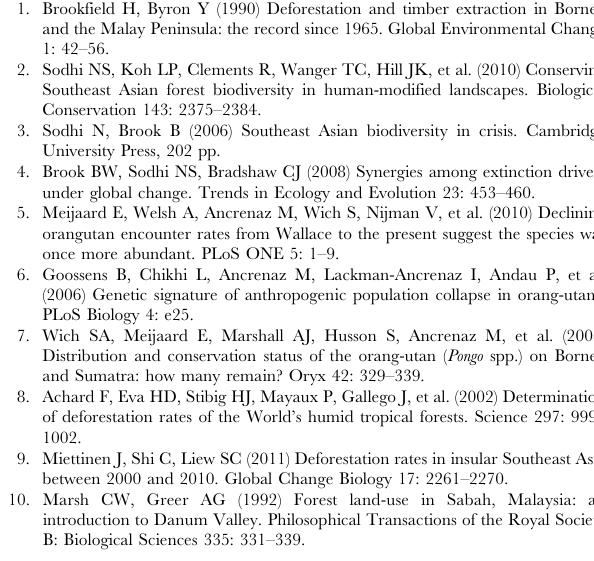
Figure S1 Predicted nest count residuals. Map of Sabah showing the residuals from the hurdle boosted regression tree Species Distribution Model. Note that the residuals are highest were the model predicted a nest count and lowest were the model predicted a nest presence. Shaded areas are commercials forest reserves and protected areas. (TIFF) Figure S2 Relationship between nest count predictions and an independent orangutan nest count dataset. Plot showing the ordinary least squares (OLS) and robust iterative re- weighted least squares (IWLS) fits when predicting our SDM model predictions with data published in [25]. Figure S3 Land-cover class gains and losses and projected changes between 2010–2100. Plots showing (a) the observed gains and losses of cells in each land cover class, and (b) the projected changes in each land class between 2010–2100 in forest reserves and unprotected forests for the current-day SFM scenario. Absolute gains and losses in least-widespread classes were negligible compared to changes in degraded land and forest cover. Consequently, projected changes in these land-cover class were inconsequential compared to projected gains and losses in degraded and forest land cover, respectively. Figure S4 Land-cover change projections. Maps showing land cover change projections at 2011, 2041, 2071 and 2100 under (a) current-day SFM and (b) complete SFM implementa- tions. Figure S5 Predictor importance for predicting 2010 observed land-cover. Plots showing the relative importance of spatial predictors in predicting observed 2010 land cover in (a) forest reserves and (b) unprotected forests.